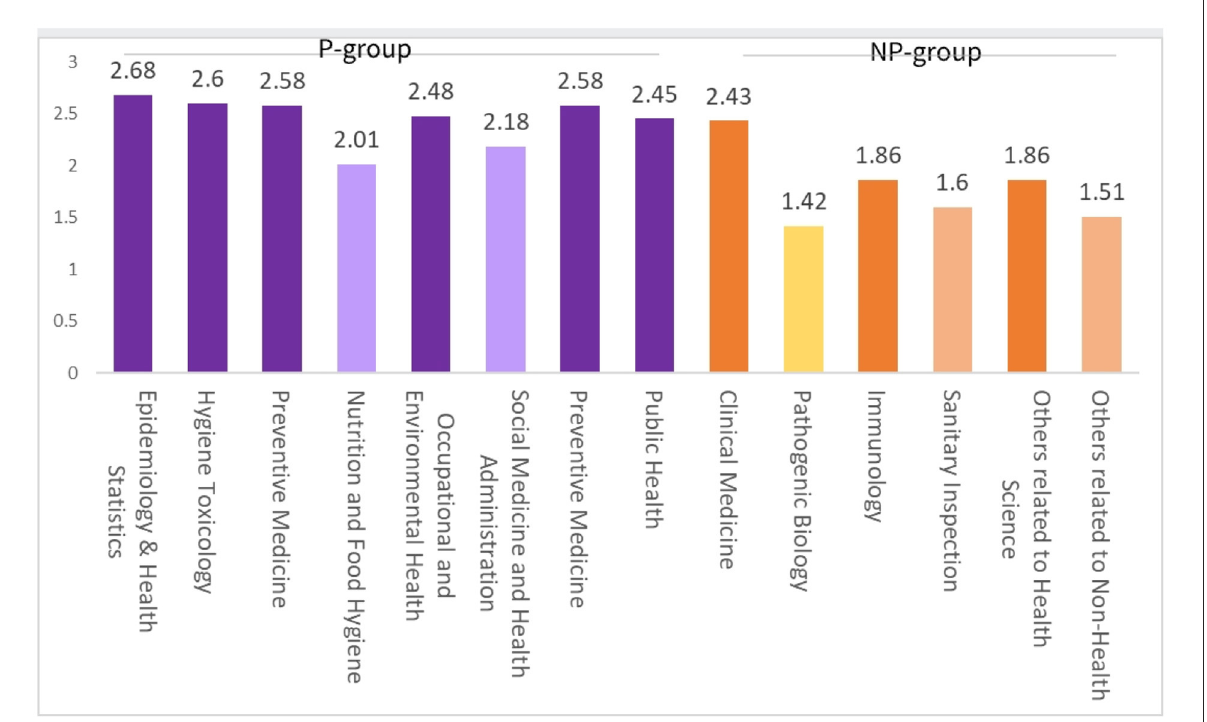
epidemic, in the P group, the Epidemiology and Health